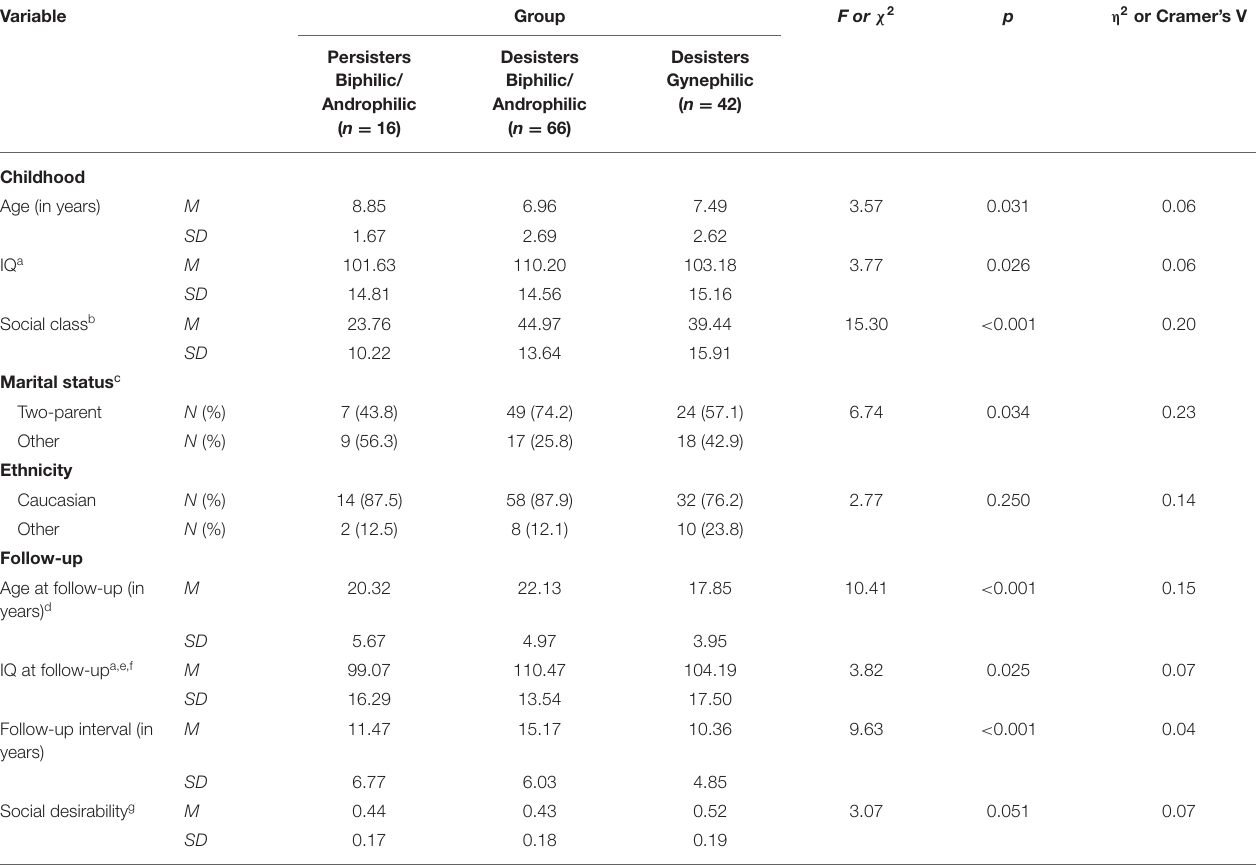
TABLE 3 | Demographic characteristics as a function of group. Variable Group F or χ 2 p η 2 or Cramer’s V